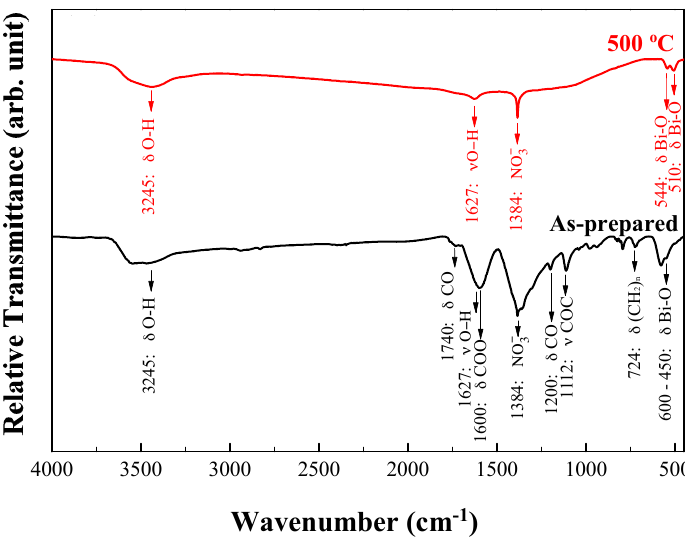
Figure 5. FT-IR spectrum of as-obtained and heat-treated Bi 2 O 3 powders prepared using the sol-gel process.